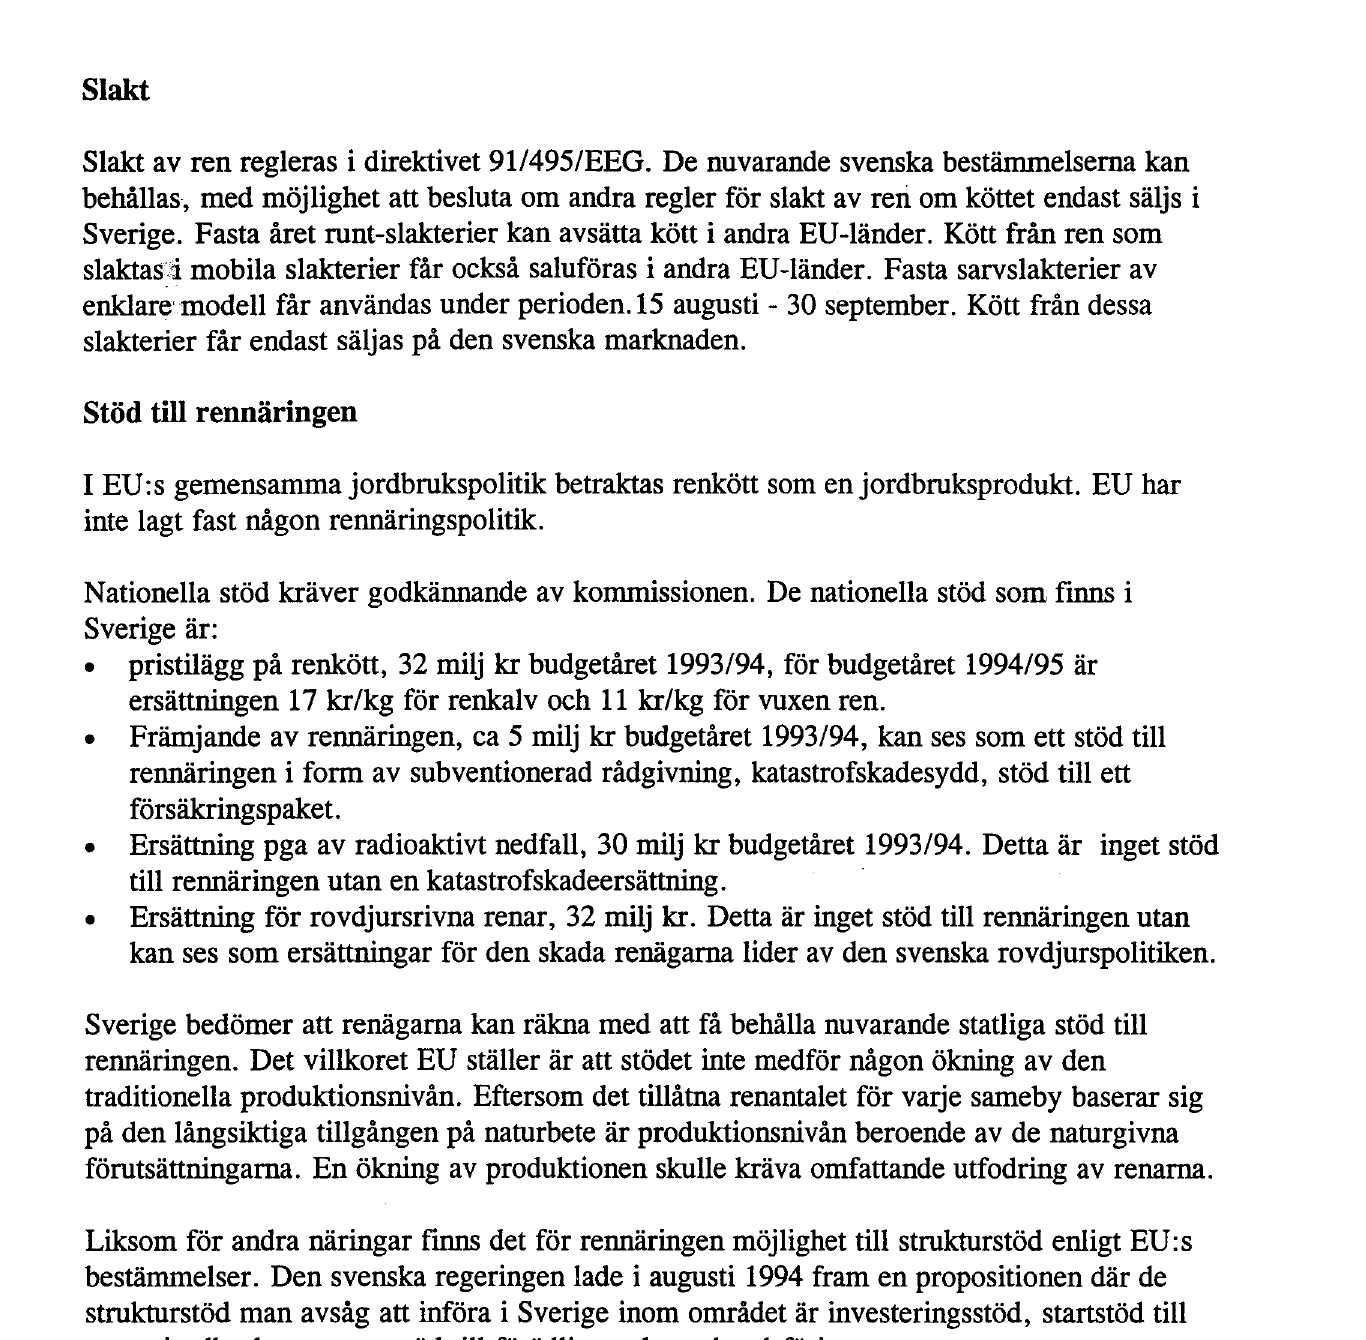
beståmmelser. Den svenska regeringen lade i augusti 1994 fram en propositionen dår de strukturstod man avsåg att inf ora i Sverige inom området år investeringsstod, startstod till yngre jordbrukare, samt stod till forådling och